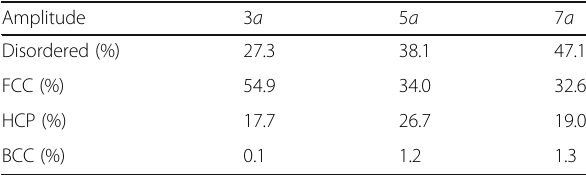
Table 3 Number fraction of atoms with different local crystalline orders in the products sintered under different